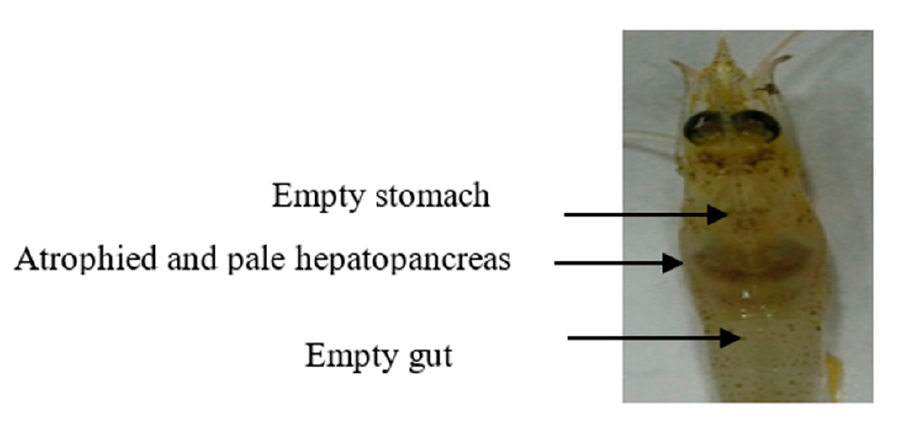
Figure 1. Clinical signs of shrimp challenged with AHPND strains.